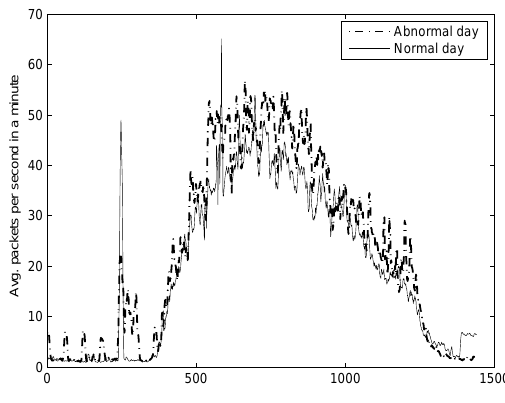
Figure 13. Average number of packets in a minute. The solid line stands for a typical day of DNS activity while the dashed line refers to abnormal activity dated 4 February 2009.